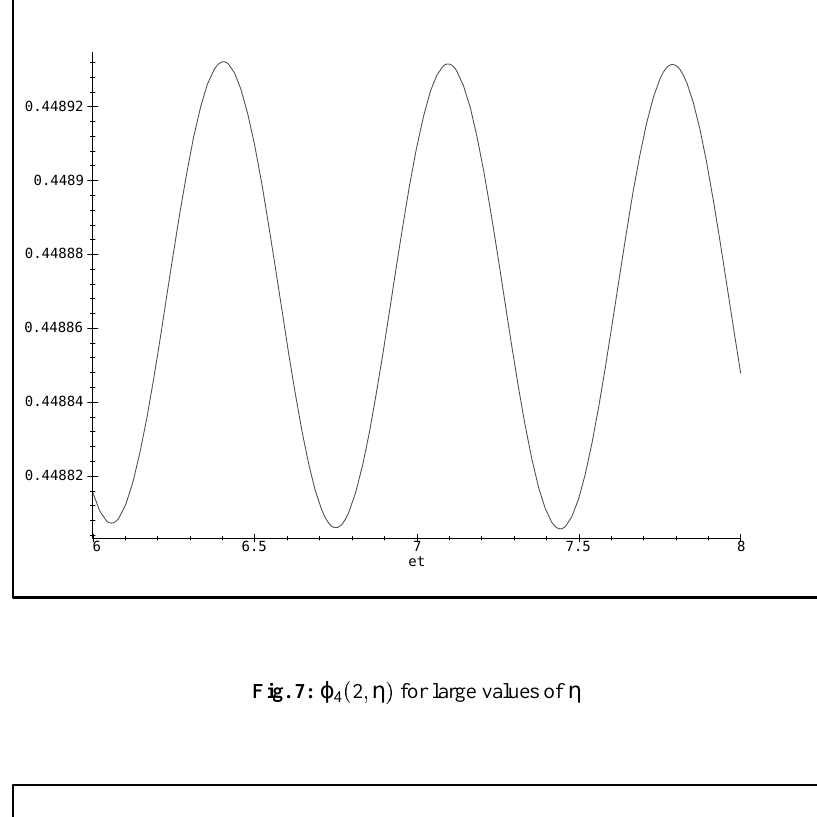
Fig. 7: j 4 (cid:0) 2